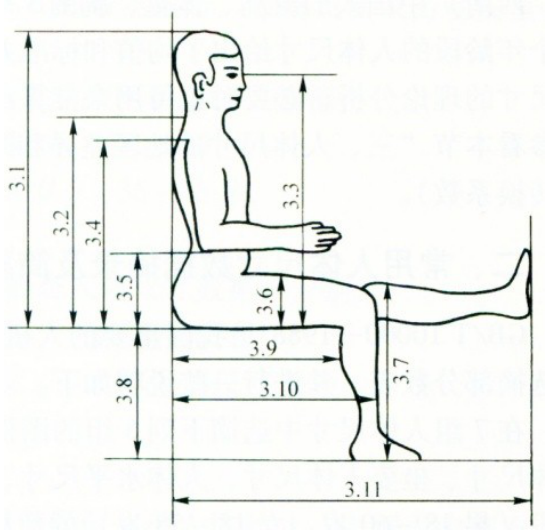
Fig. 1 Sitting body dimension.